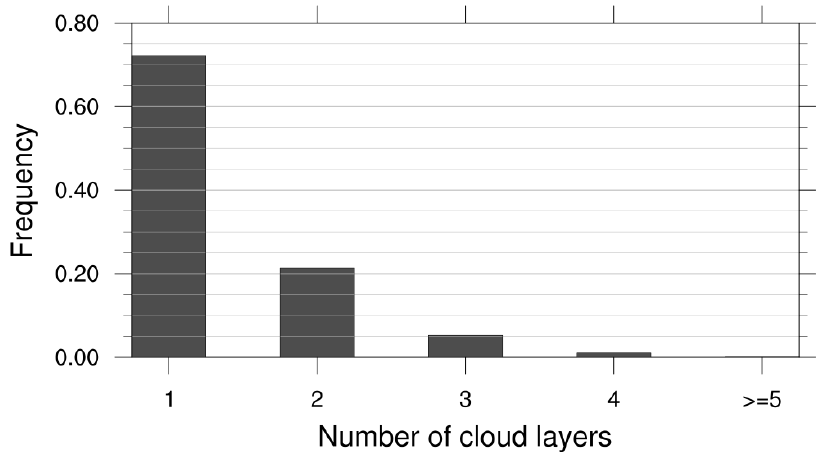
Figure 1. Occurrences of cloud profiles with diverse cloud layers over global oceans.